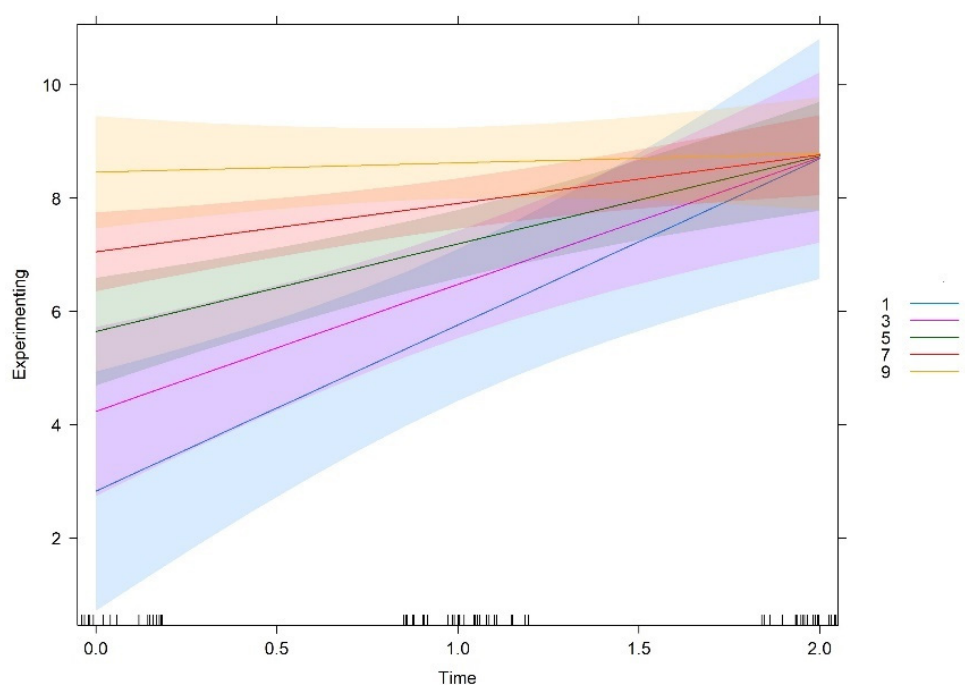
Figure 4. Interaction effect between time and goal.